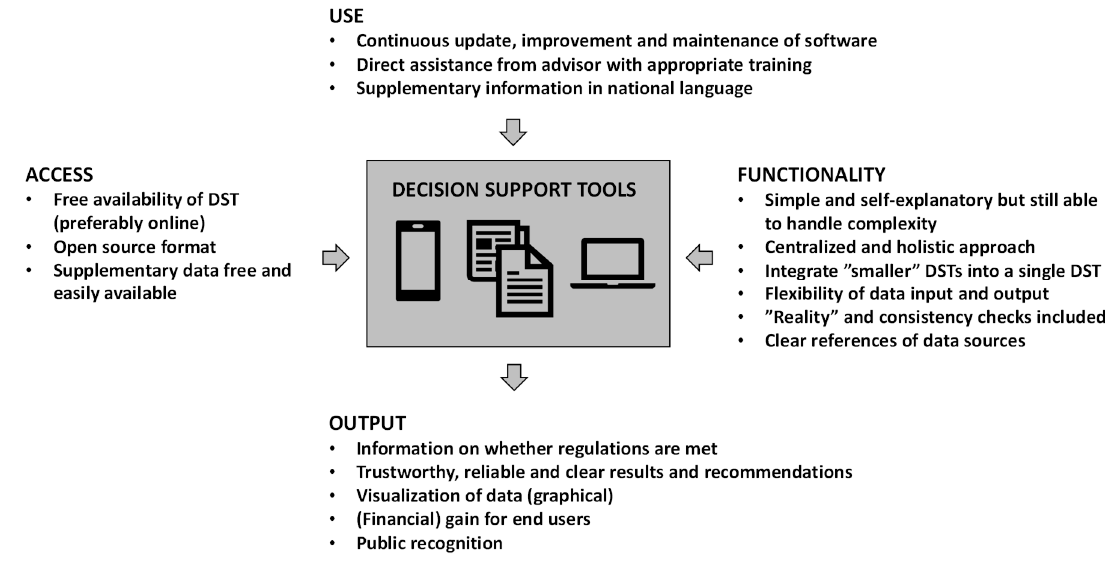
Figure 4. Criteria to be fulfilled by DSTs as identified by end users in nine FAIRWAY case studies.